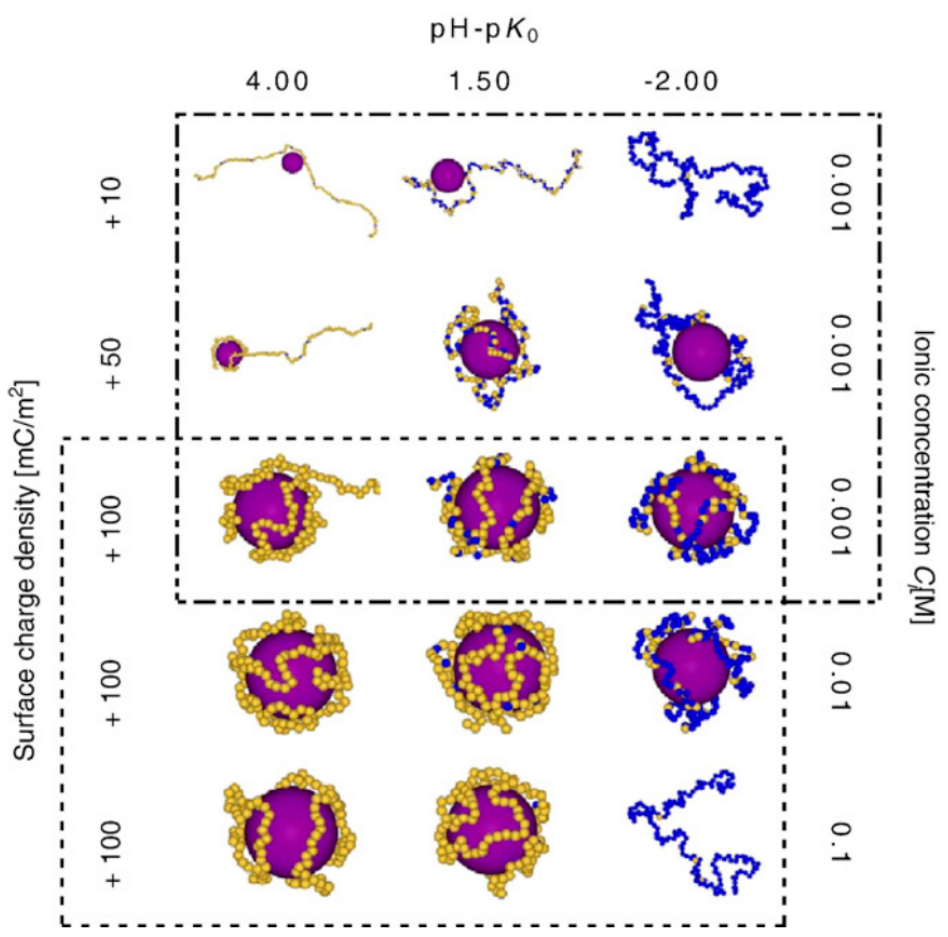
Figure 4. Conformations of complexes of a weak and flexible acid PE with N = 160 monomers and an oppositely charged nanoparticle with radius R = 3.57 nm, for different pH and ionic strength of the bulk solution and surface charge density, as indicated in the plot. Yellow spheres represent charged deprotonated momoners; blue spheres represent uncharged protonated ones. (Reprinted with permission from the authors of [99]. Copyright 2006